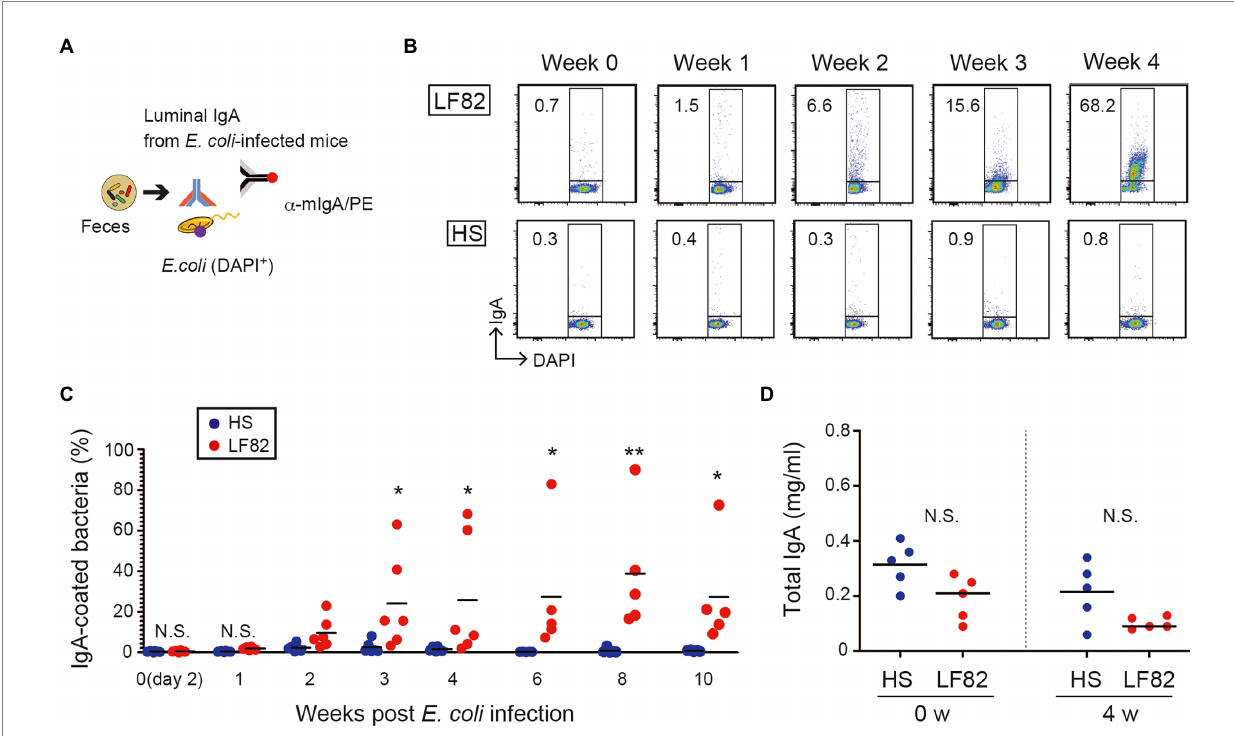
FIGURE 2 Persistent colonization of AIEC induces bacterial specific IgA but not non-AIEC colonization. (A) Luminal IgA (L-IgA) was prepared from feces of infected mice every week and analyzed for their ability to bind to bacteria. (B) The production of L-IgA in response to LF82 (upper panels) or HS (lower panels) was analyzed by flow cytometry. The numbers in the panels indicate the percentage of IgA + fraction within the DAPI + total bacteria. (C) The kinetics of IgA production in infected mice. The binding of each IgA fraction to bacteria was determined as shown in a. (D) Total IgA concentration was